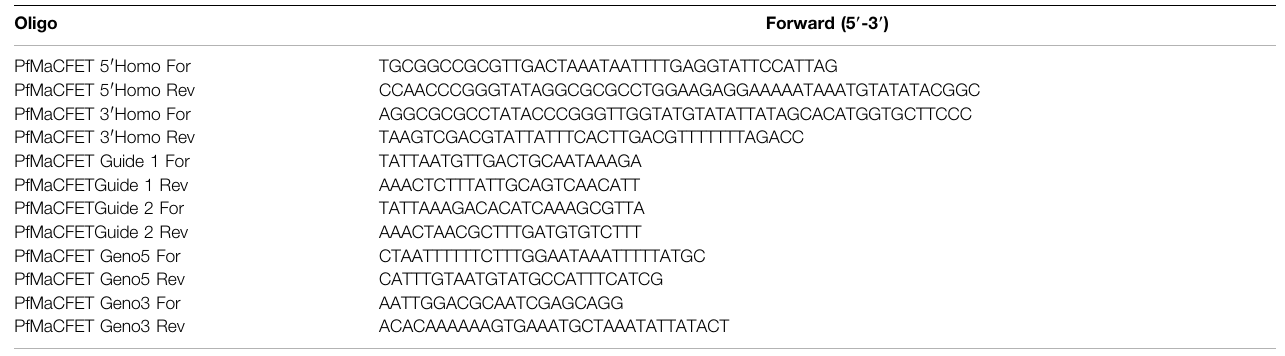
TABLE 1 | Oligonucleotides used in the study. Oligonucleotides used for generation of Pf macfet (cid:1) parasites